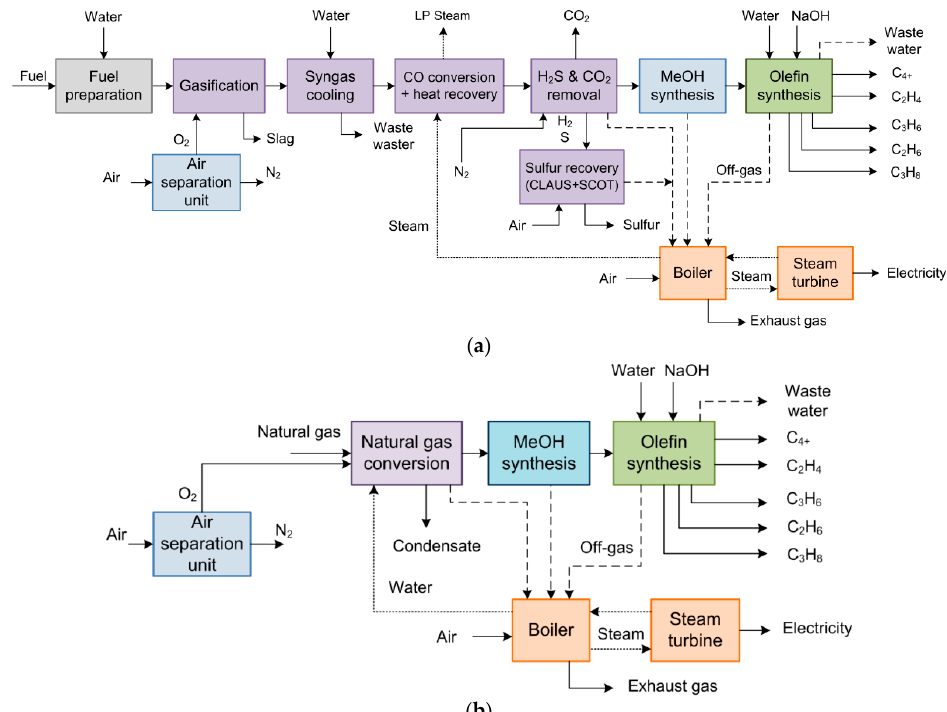
Figure 2. Technological configuration of the olefins production system: ( a ) solid fuels, ( b ) gaseous fuels.